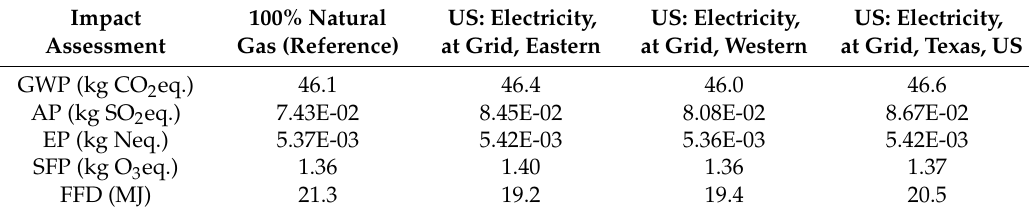
Table 9. E ff ect of electricity grid mix on the environmental-impact